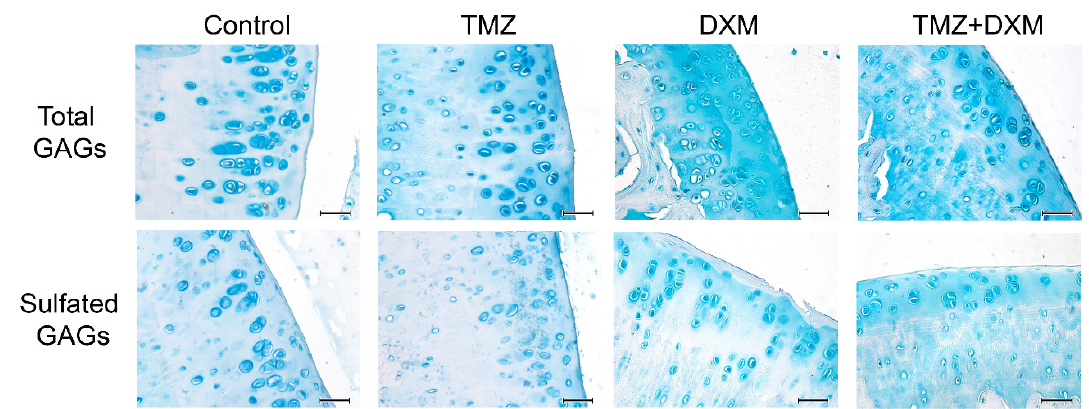
Figure 4. The content of GAGs in the knee joint cartilage of Wister rats treated with TMZ and/or DXM. Representative fragments of thefemoral and tibial epiphysis from the healthy (control), TMZ-, DXM-, and TMZ + DXM-treated experimental animals. Alcian blue staining for total GAGs (pH = 2.5) or sulfated GAG (sGAG, pH = 1.0). Magnification ×400. Scale bars 50 μ m. TMZ – temozolomide,